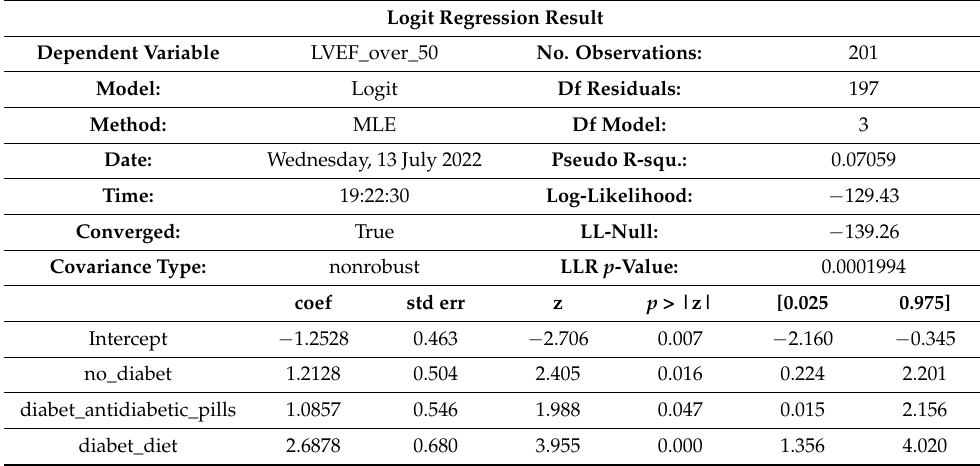
Table 5. Logistic regression output for variables related to